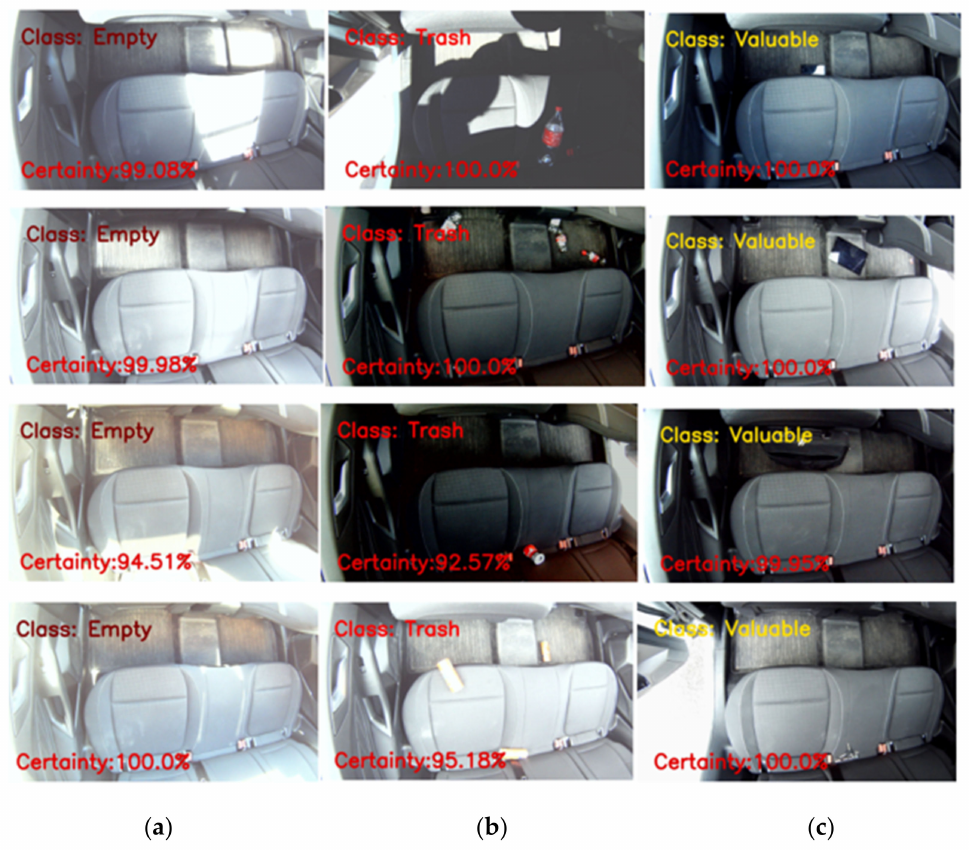
Figure 9. Images from Figure 6 annotated with the classification and probability of certainty for the distinct classes ( a ) empty, ( b ) trash and ( c ) valuable.